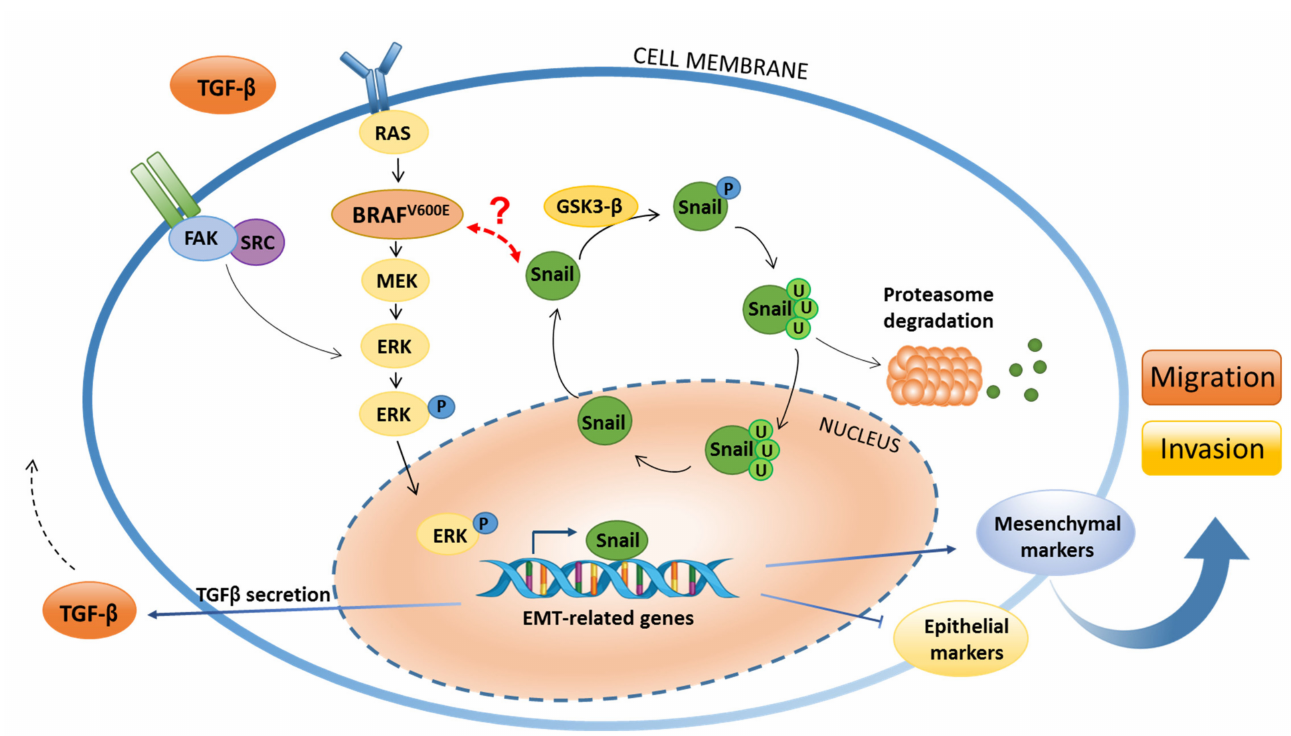
Figure 2. Scheme of the interactions between BRAF V600E and Snail-1 that are regulated via the GSK3- β kinase in a thyroid carcinoma